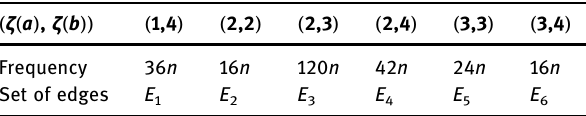
Table 5: Edge partition of MOPs based on degrees of end vertices of each